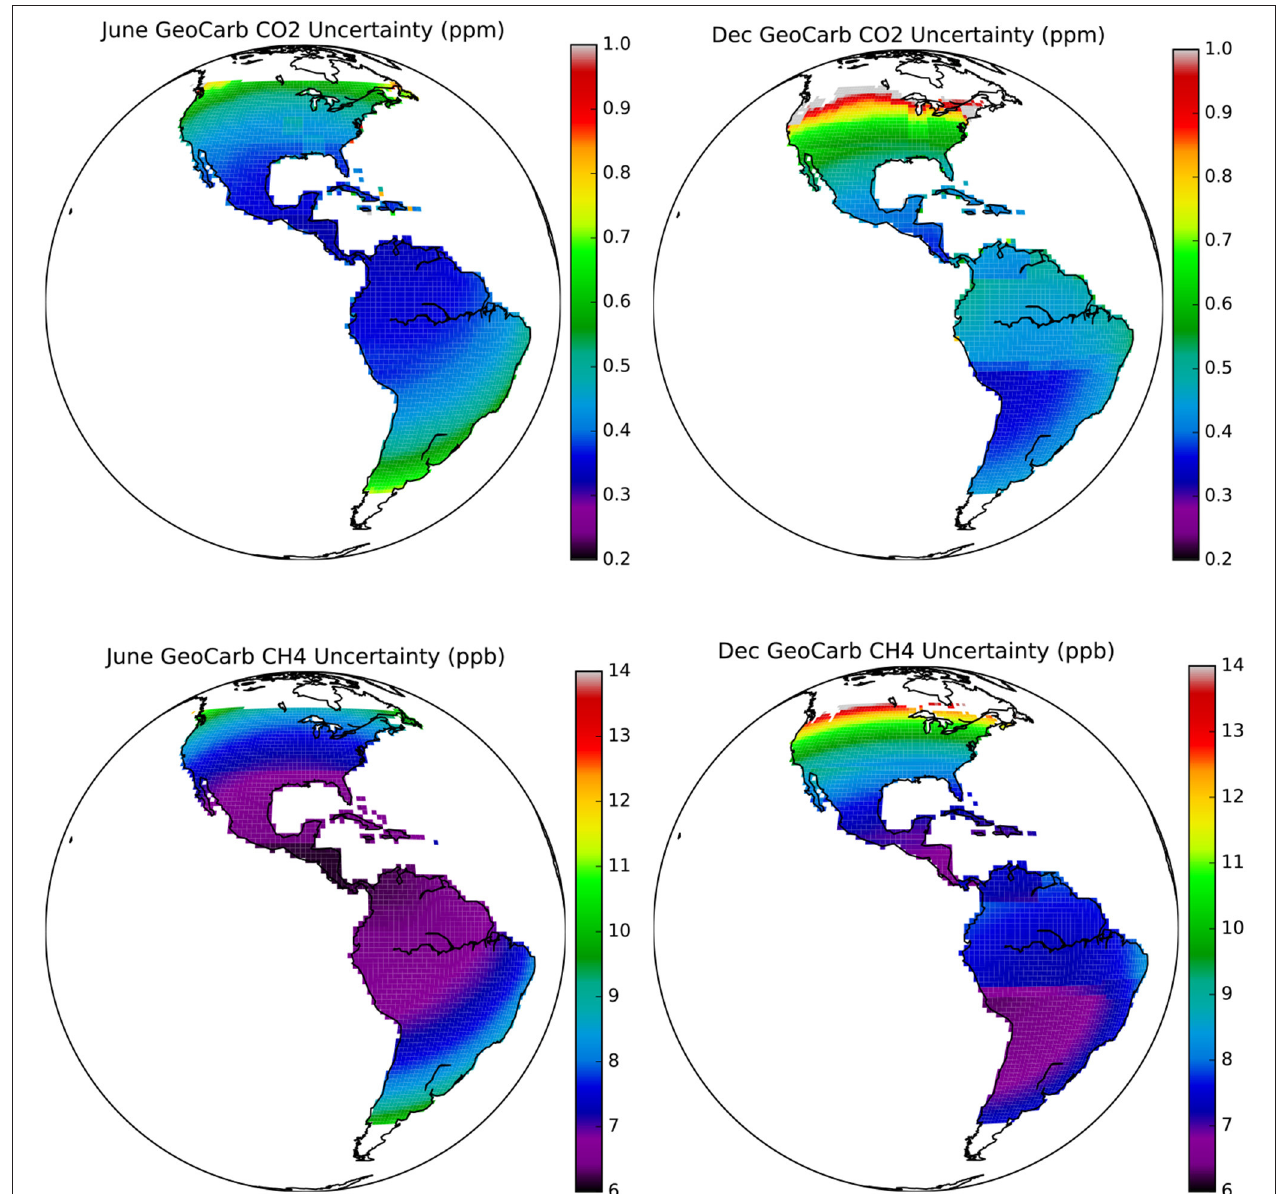
FIGURE 3 | GeoCarb 1 ◦ × 1 ◦ CO 2 uncertainty (Top) and CH4 uncertainty (Bottom) consisting of both random and correlated systematic errors, but without the extra scaling by 2.5 that accounts for a spatial correlation length scale of 2 ◦ . For June (Left) , the uncertainties are largely driven by the systematic errors parametrized in terms airmass factor, while in December (Right) , we see the impacts of cloudiness and lower surface albedos in the Amazon region in the reduced number of soundings as evinced by the larger uncertainties than would be apparent in airmass alone.